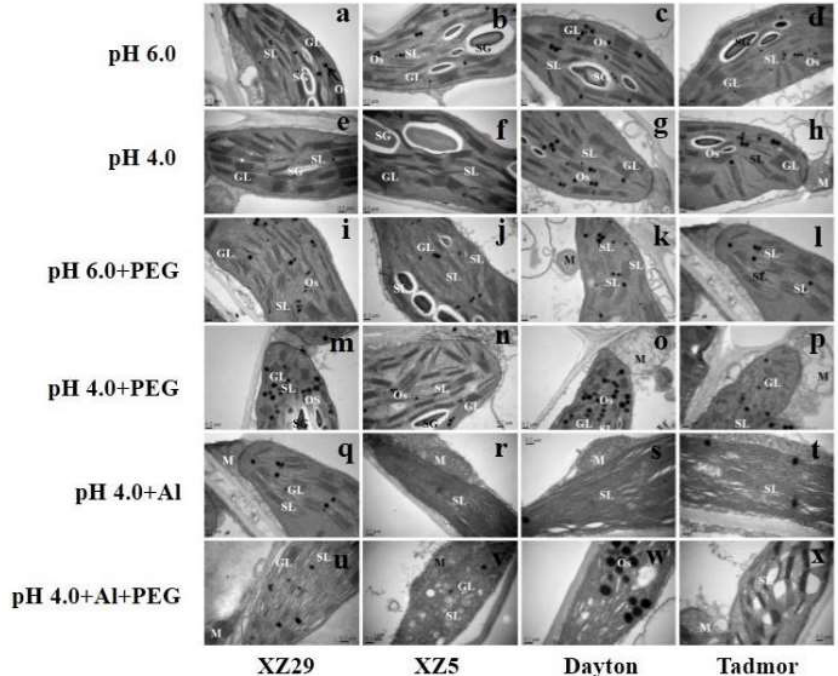
Figure 7. Transmission electron micrograph of chloroplasts of Tibetan wild barley XZ29 (left panel), XZ5 (left middle) and cv. Dayton (right middle), Tadmor (right panel) grown under pH 6.0 (a, b, c, d), pH 4.0 (e, f, g, h), pH 6.0+PEG (i, j, k, l), pH 4.0+PEG (m, n, o, p), pH 4.0+Al (q, r, s, t) and pH 4.0+Al+PEG (u, v, w, x) stresses respectively, for seven days. All individual figures scale bar = 0.2 μm. GL, granum lamellae; M, mitochondrion; Os, osmophilic plastoglobuli; SG; starch grain; SL, stroma lamellae; CW, cell wall.